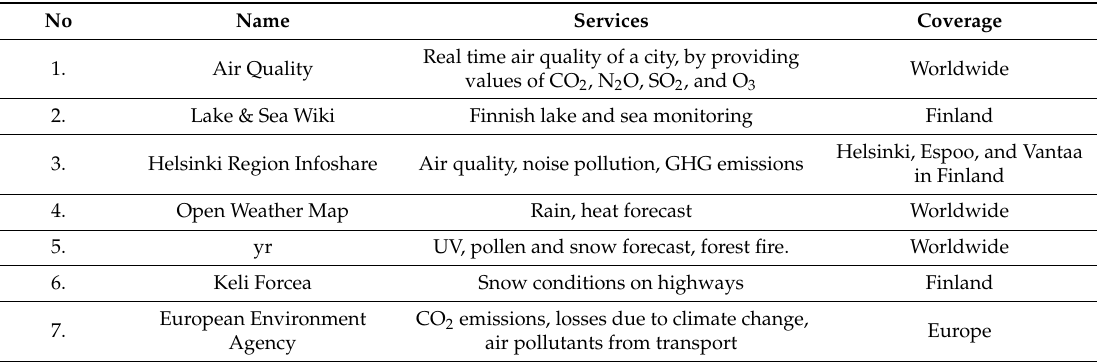
Table 1. List of open data services for environmental monitoring. GHG—greenhouse gas; UV—ultraviolet.